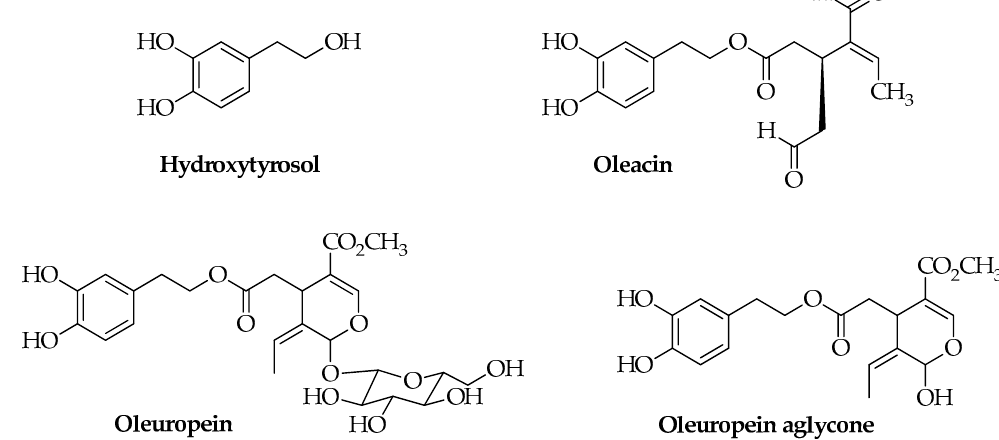
Figure 1. Chemical structures of hydroxytyrosol and derivatives found in EVOO.